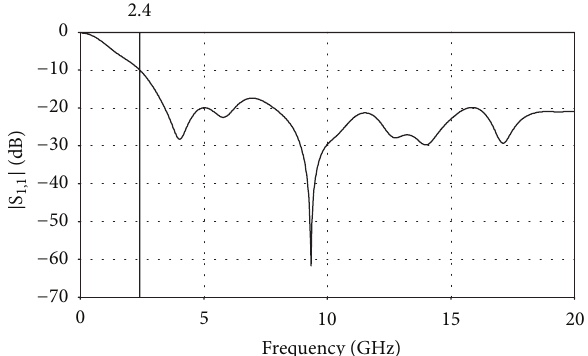
Figure 4:Reflection coefficient magnitude ofa conical antenna with elliptical